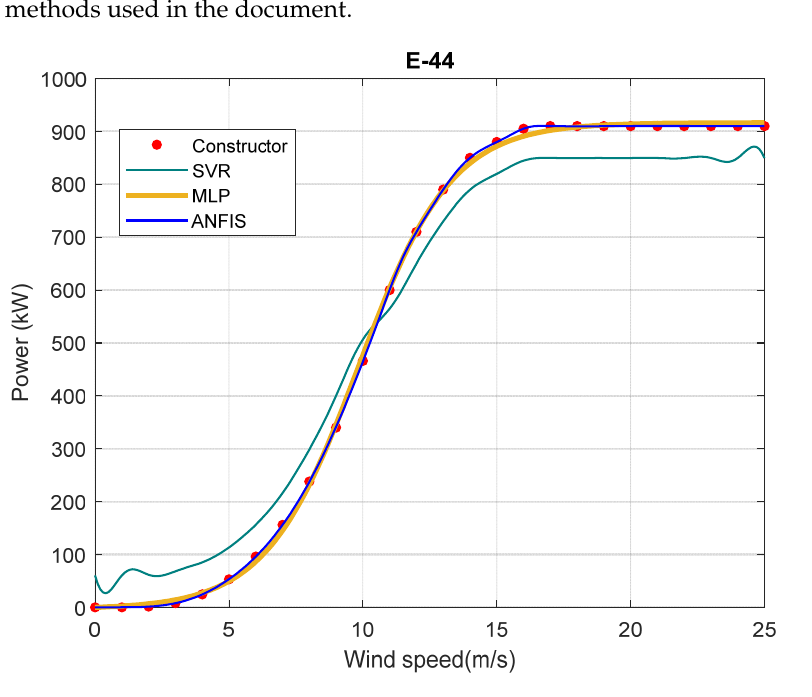
Table 3. Average annual energy output at different hub